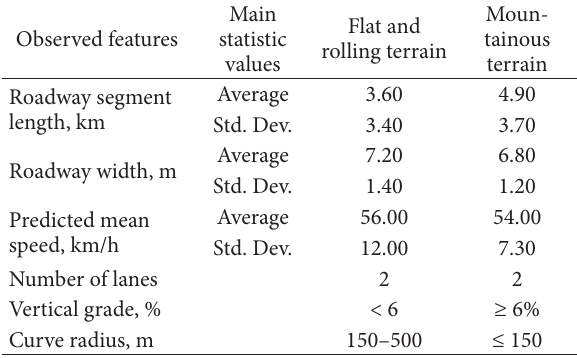
Table 1. Geometric features of the low-volume roads analyzed Observed